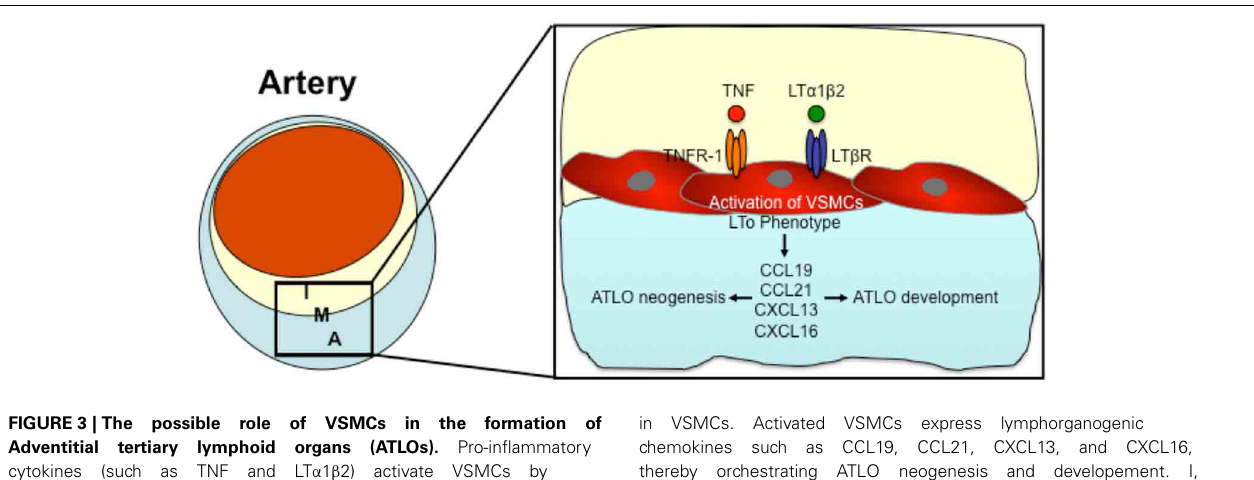
FIGURE 3 | The possible role of VSMCs in the formation of Adventitial tertiary lymphoid organs (ATLOs). Pro-inflammatory cytokines (such as TNF and LT α 1 β 2) activate VSMCs by TNFR-1 or LTßR signaling thereby inducing an LTo phenotype